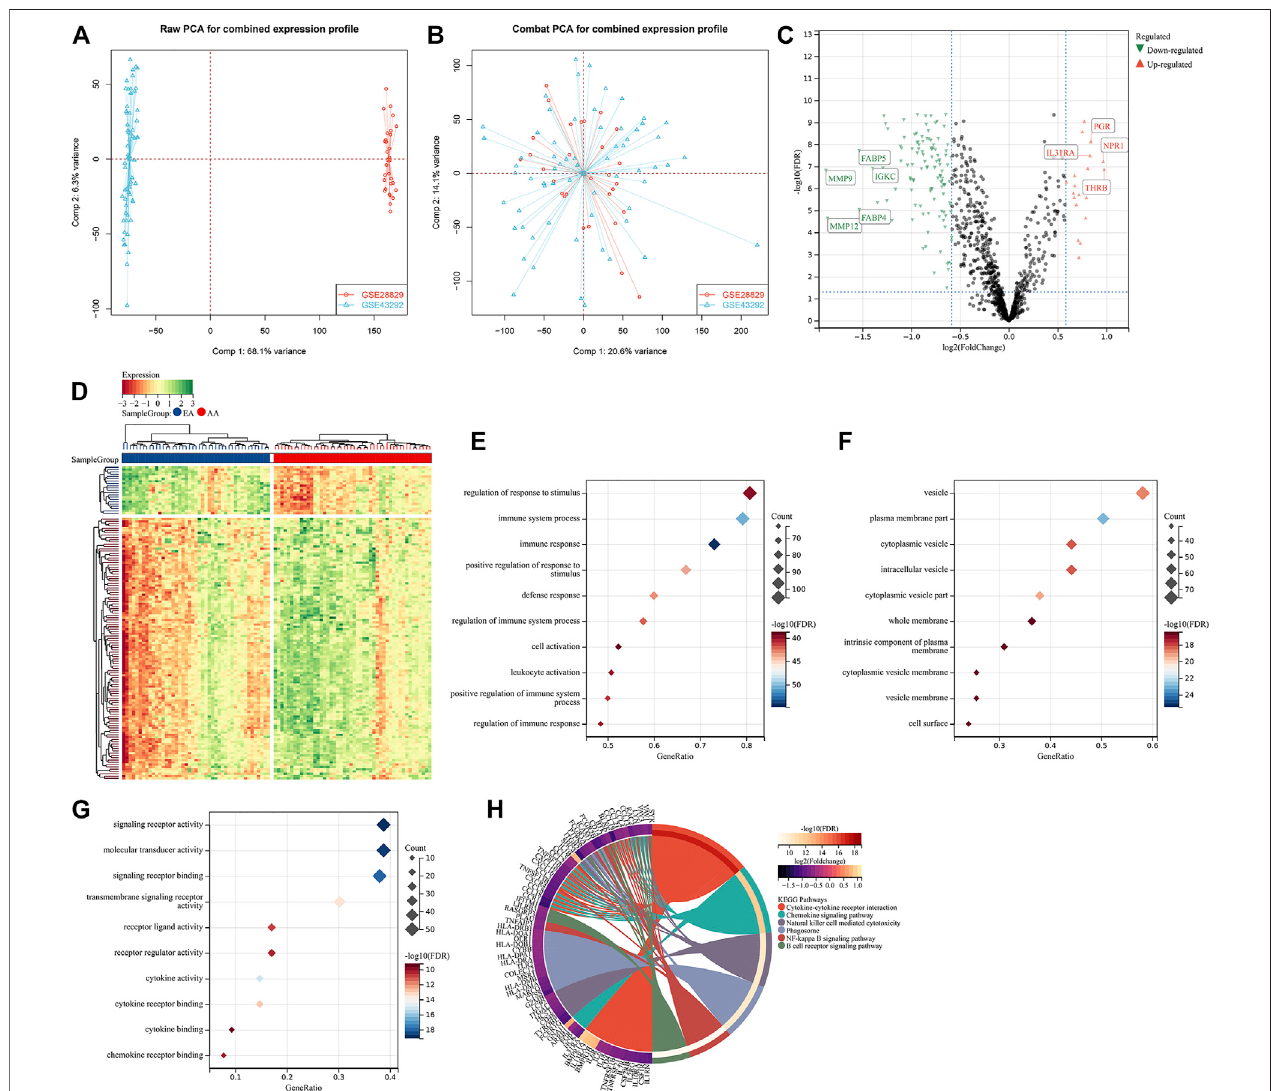
FIGURE1| Identi fi cationofatheroscleroticplaqueprogression-andimmune-associatedgenesinthecombinedexpressionpro fi lingofGSE28829andGSE43292 cohorts. (A) PCA plots showing the combined expression pro fi ling of GSE28829 and GSE43292 cohorts. (B) PCA plots showing the combined expression pro fi ling of GSE28829 and GSE43292 cohorts after batch effects. (C) Volcano plots depicting the RNA expression levels of the immune-associated genes between early- stage and advanced-stage carotid atherosclerotic plaque specimens. (D) Heatmap showing the differentially expressed immune-associated genes between the aforementioned groups. AA: advanced-stage atherosclerotic plaque; EA: early-stage atherosclerotic plaques. (E – G) Main BPs, CCs, and MFs enriched by atherosclerotic plaque progression- and immune-associated genes. (H) Main KEGG pathways enriched by the above genes.